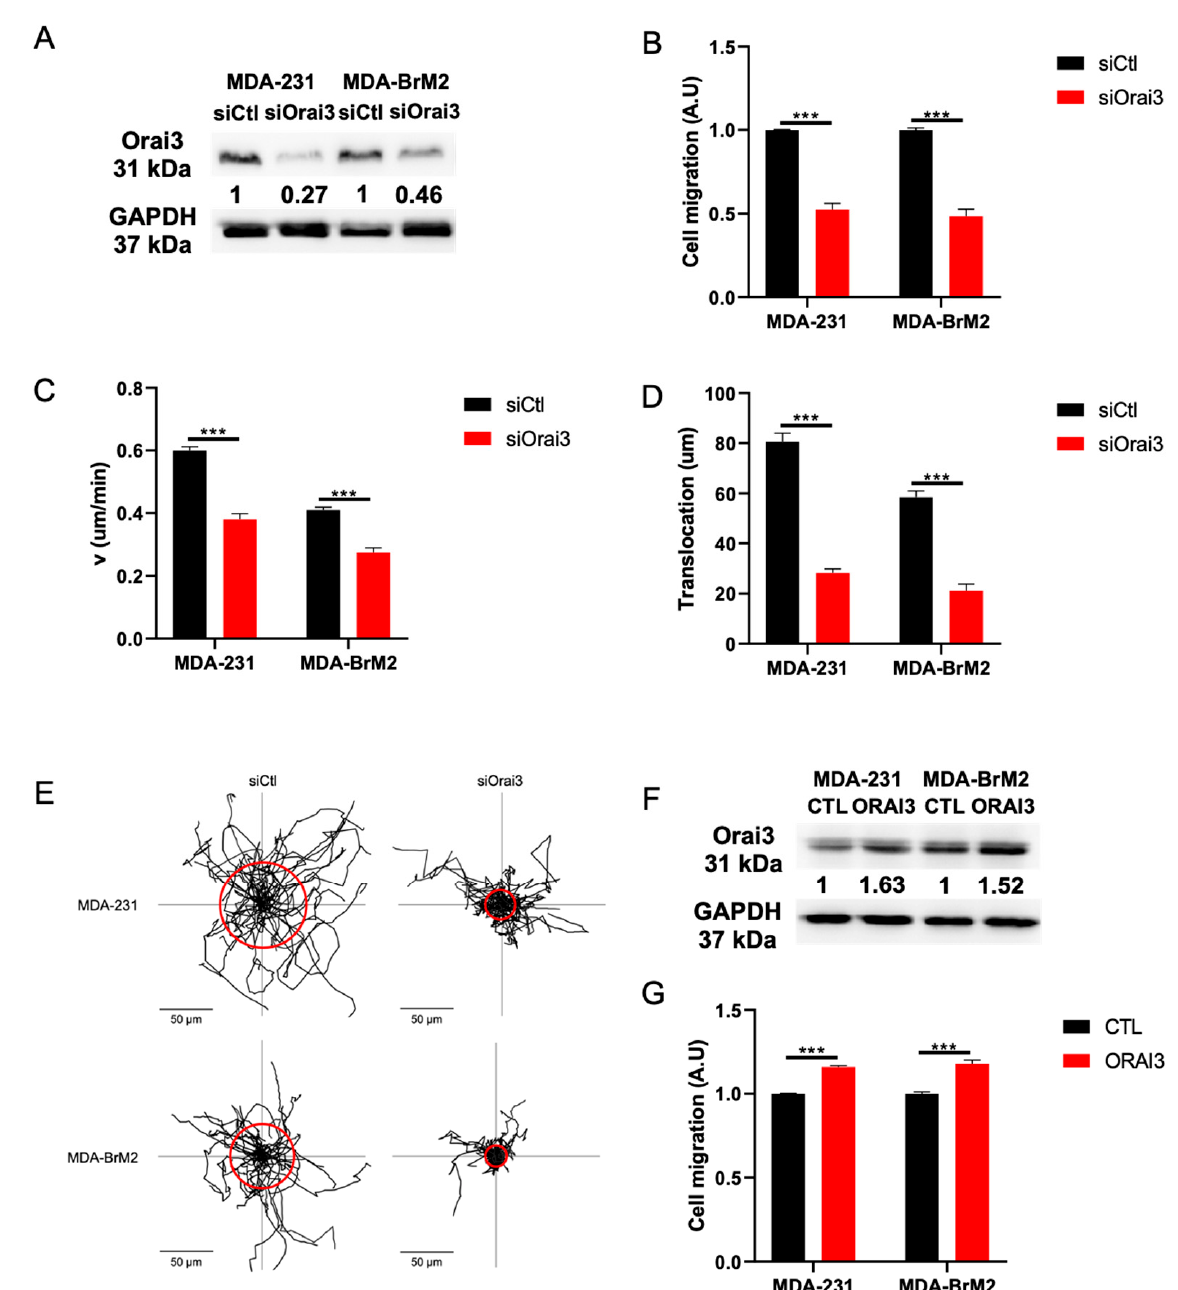
Figure 1. Orai3 regulates basal-like breast cancer cell migration. ( A ) Orai3 expression evaluated by Western Blot 72 h post transfection (N = 3; *** p < 0.001). ( B ) Orai3 activity regulates MDA-231 and MDA-BrM2 cell migration. Cell migration experiments were performed using Boyden chambers (N = 3; *** p < 0.001). ( C , D ) Both cell migration speed ( C ) and translocation ( D ) are impaired by siOrai3. Summary of the migration experiments shown in E and evaluated by live-cell imaging (MDA-231 siCtl n = 49; MDA-231 siOrai3 n = 43; MDA-BrM2 siCtl n = 39; MDA-BrM2 siOrai3 n = 42; N = 3; *** p < 0.001). ( E ) Trajectories of migrating cells in siCtl and siOrai3 MDA-231 and MDA-BrM2 cells. The radius of the red circles illustrates the mean translocation of each condition (Scale bar: 50 µ m). ( F , G ) Orai3 overexpression increases protein expression levels ( F ) as well as MDA-231 and MDA-BrM2 cell migration ( G ). Cell migration experiments were performed using Boyden chambers (N = 3; *** p < 0.001).